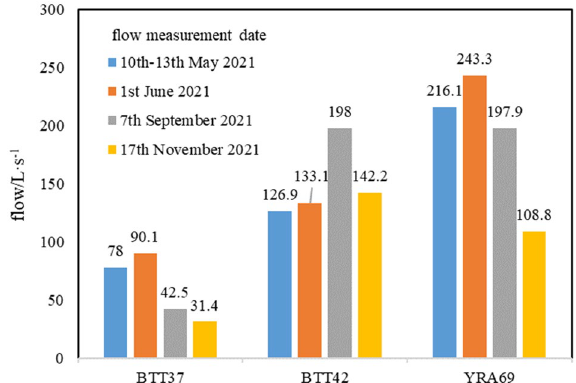
Figure 3. Flow of main karst springs within the study area.